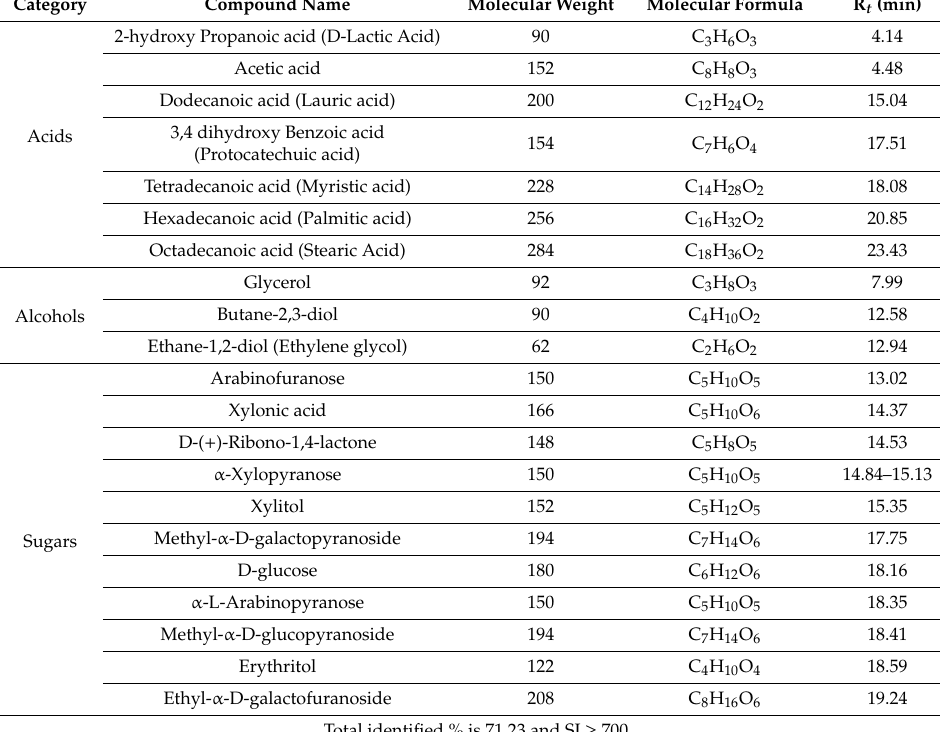
Table 2. Identified compounds of silylated metabolites of C. vitellina extract using